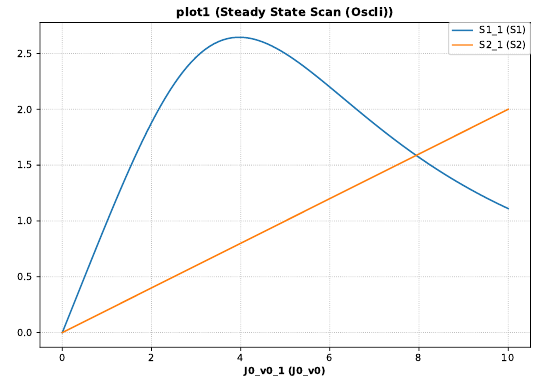
Figure A.5: The simulation result from the simulation description given in List- ing A.4. Simulation with SED-ML web tools [2].